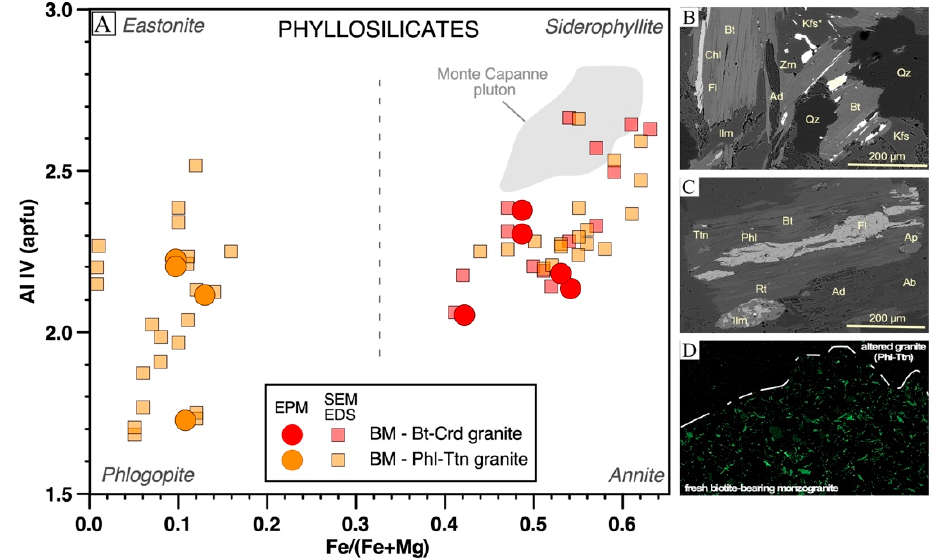
Figure 5. ( A ) Classification diagram of the phyllosilicates [23] from the BM granite (circle = electron